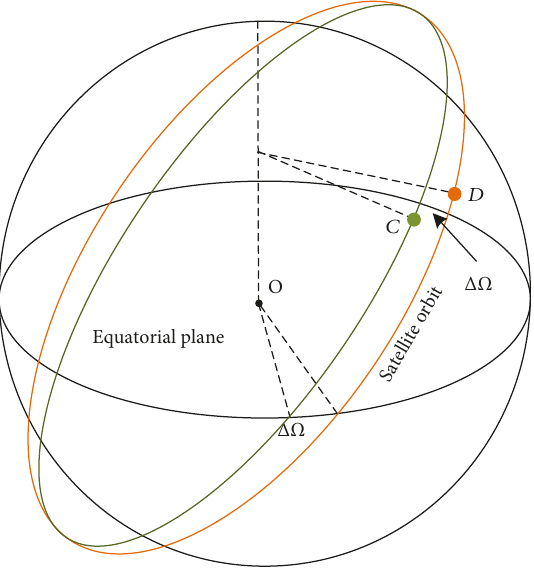
Figure 2: The geometry of two identical orbits with a di ff erent RAAN, ΔΩ , shown in the inertial reference